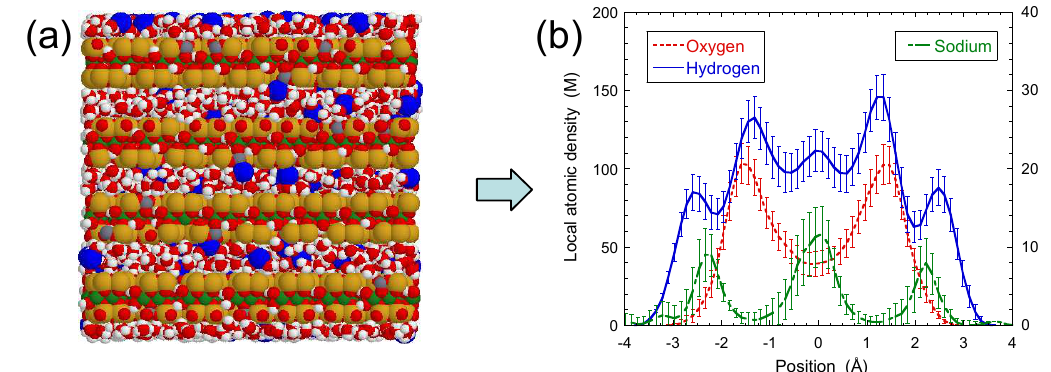
Figure 2. ( a ) Snapshot illustrating one Grand Canonical Monte Carlo (GCMC) equilibrium configuration of confined water molecules and neutralizing sodium counterions; ( b ) concentration profiles of sodium counterions and oxygen and hydrogen atoms pertaining to water molecules confined between two beidellite clay lamellae. Reprinted with permission from [53]. Copyright (2014) American Chemical Society.